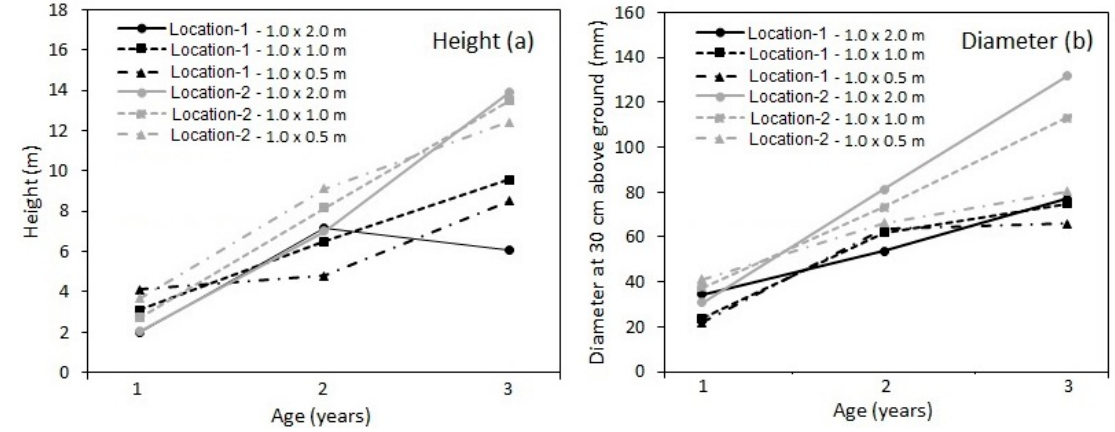
Figure 1. Height ( a ) and diameter ( b ) in short rotation energy plantations of Gmelina arborea in two different locations in Costa Rica. Table 4. F-values from ANOVA for diameter, height and biomass in short rotation energy plantations of Gmelina arborea in two different locations of Costa Rica.